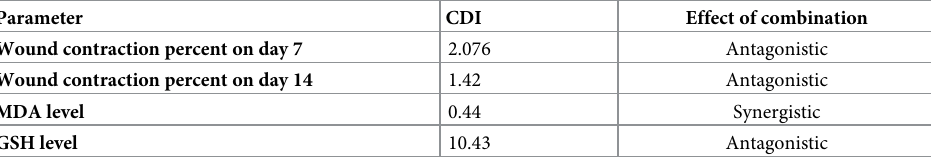
Table 4. Nature of interaction between tea tree and rosemary essential oils as determined by